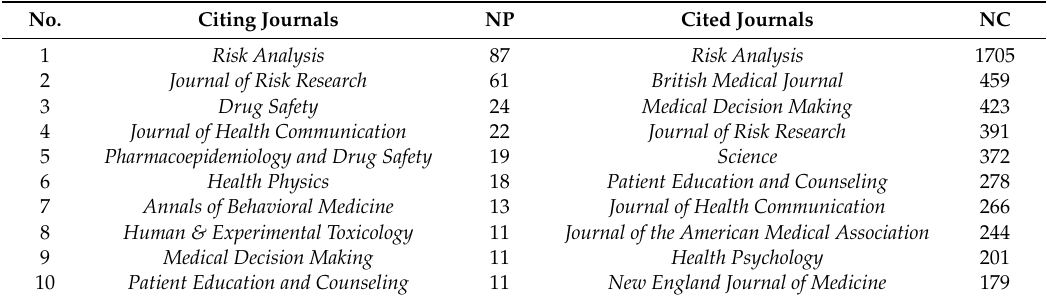
Figure 5. Dual-map overlay of risk communication papers on the global science map, on the basis of journals. Table 5. Top 10 highly productive journals and highly cited journals in risk communication